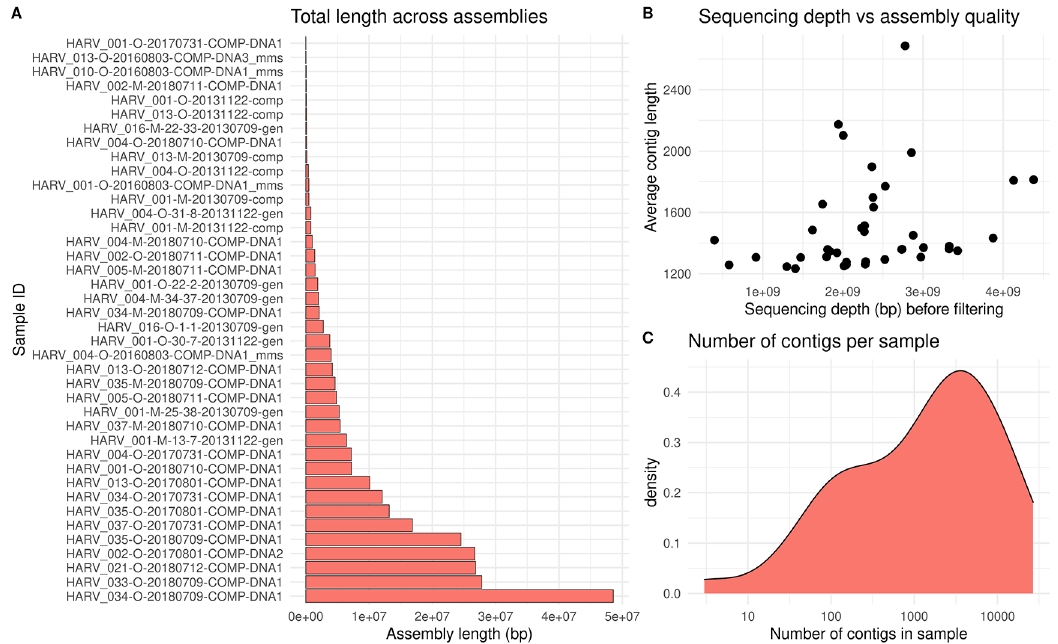
Figure 3. Results of contig assembly of short-read quality-filtered metagenomic samples. Contigs were assembled using the Megahit software, with samples from the Harvard Forest site of the National Ecological Observatory Network (NEON). The “ meta-large ” preset was used with a minimum contig length of 1000 base pairs (bp). a) Assembly length per sample, calculated as the sum of contig lengths within sample. b) Average contig length persample,plottedagainstthesequencingdepthbeforefiltering.c)Densityplotshowingthenumberofcontigsper